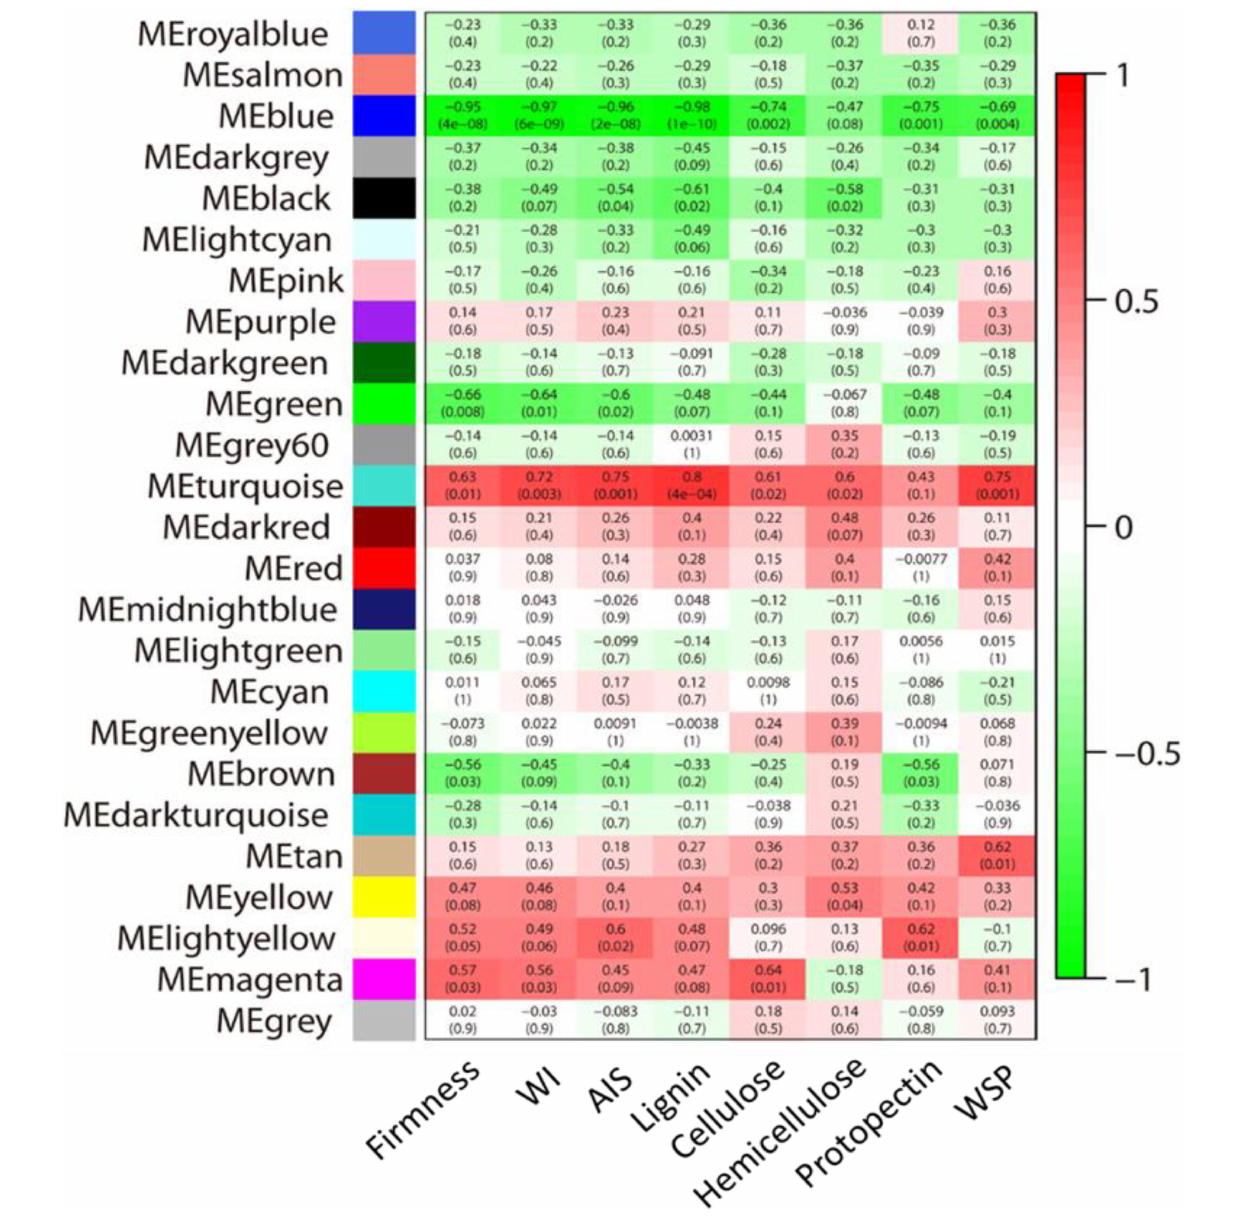
FIGURE 7 | Module-trait relationship analysis by WGCNA. Numbers in the squares presented the module-trait correlations (with corresponding p -values in parentheses). The color scale represents the module-trait correlations from –1 (green) to 1 (red). Panels WI, AIS, and WSP represent the whiteness index, alcohol insoluble solids, and water-soluble pectin,